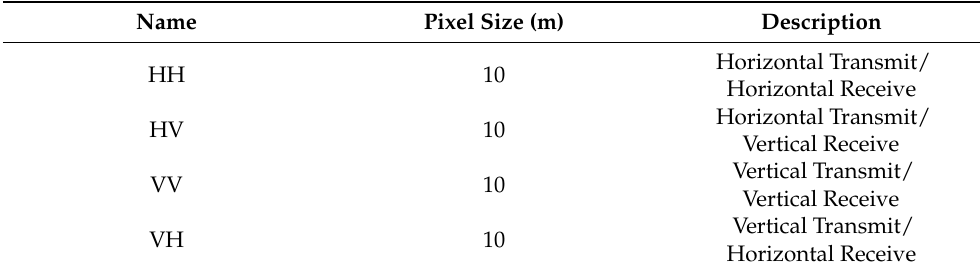
Table 1. Description of possible polarization bands with respective pixel size in Sentinel-1 SAR GRD: C-band